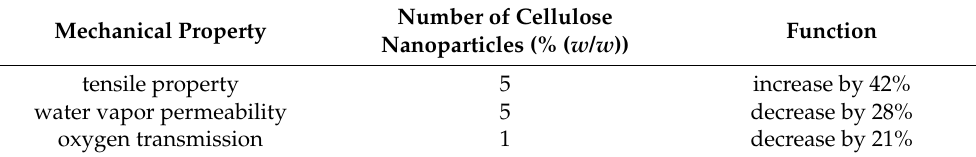
Table 5. Mechanical properties of polymer composites with included cellulose nanoparticles [179]. Number of Cellulose Function Mechanical Property Nanoparticles (% ( w / w )) tensile property 5 increase by 42% water vapor permeability 5 decrease by 28% oxygen transmission 1 decrease by